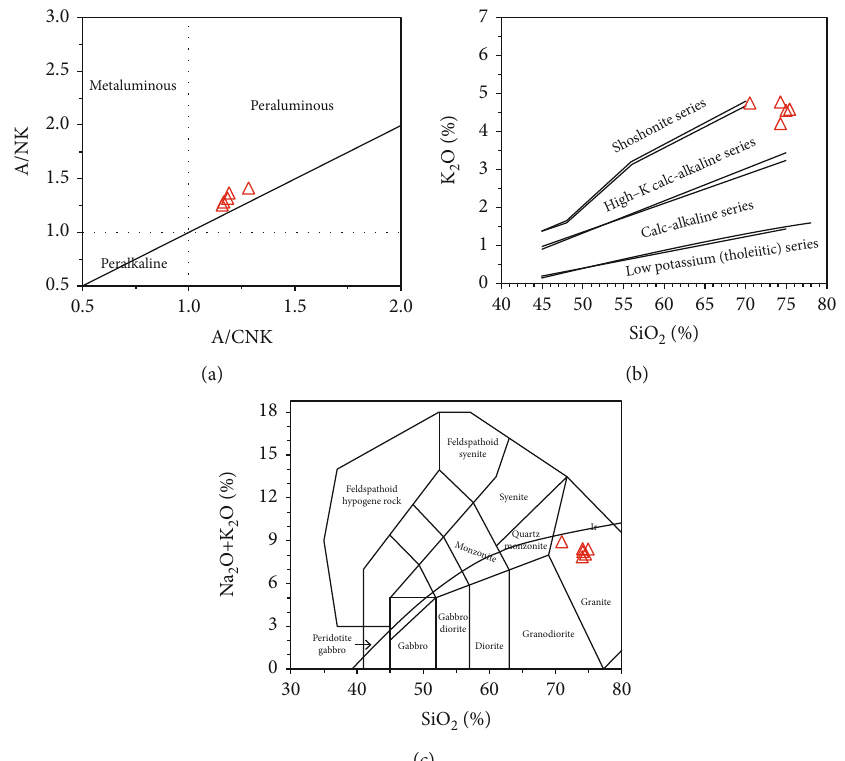
Figure 4: Diagrams of A/NK-A/CNK (a, after [31]), K